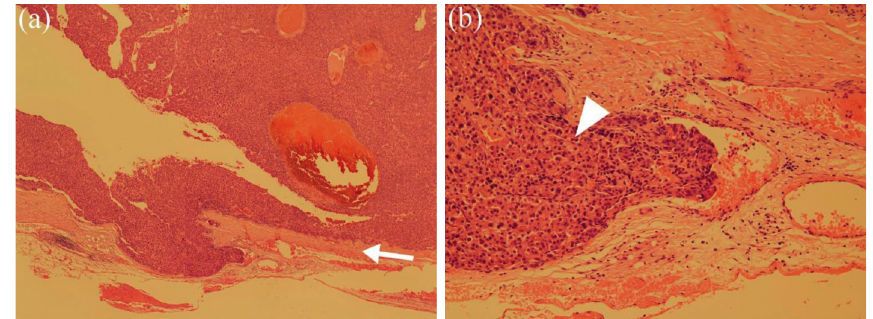
Figure 3: Microscopic pathological examination of the tumour. (a) There was no obvious gastric serosa (arrow) exposure of the tumour (haematoxylin and eosin stain, original magnification × 20). (b) Moderately differentiated hepatocellular carcinoma (arrowhead) (hae- matoxylin and eosin stain, original magnification ×